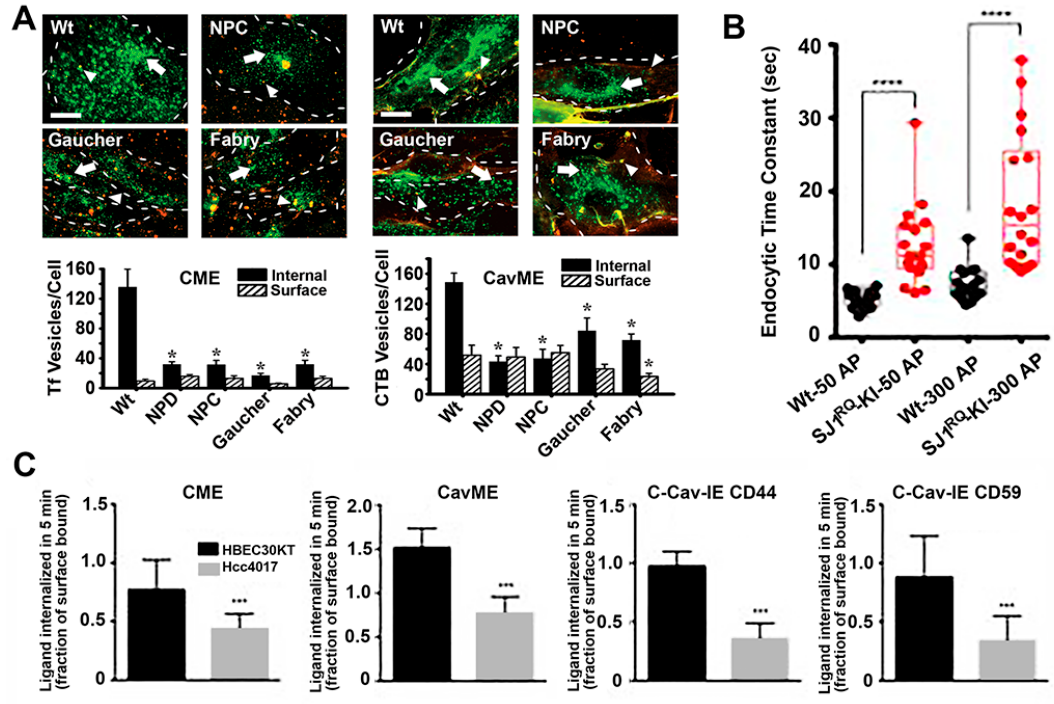
Figure 3. Endocytic alterations caused by disease. ( A ) Micrographs (top panels) and image quantification (bottom graphs) of the uptake of transferrin (Tf; left side) via clathrin-mediated endocytosis (CME) or cholera toxin B (CTB; right side) via caveolae-mediated endocytosis (cavME) in fibroblasts from wild-type (Wt) individuals or patients of Niemann–Pick type A (NPD), Niemann–Pick type C (NPC), Gaucher and Fabry diseases. Green: internalized ligand; yellow-red:cell surface-bound ligand; dashed lines: cell borders; scale bar: 10 μ m. * p < 0.05, Student's t test. ( B ) Endocytosis time constants after short (50 action potentials) or long (300 action potentials) stimulation of cortical neurons from Wt mice vs. mice expressing Parkinson-like R258Q mutation in synaptojanin 1 (SJ1), a molecule involved in synapse endocytic signaling. **** p < 0.00001, Mann–Whitney U test. ( C ) Uptake of endocytic markers in HBEC30KT normal cells vs. Hcc4017 cancer cells from the same patient. C-Cav-IE: Clathrin- and caveolae-independent endocytosis. *** p < 0.0005, Student's t test. Data are mean ± standard error of the mean (SEM) for (A) and (B), and standard deviation (SD) for (C). Adapted and reproduced with permission from: ( A ) Figures 4 and 5 in [94]; ( B ) Figure 5B in [95]. Copyright 2017 Elsevier Inc.; ( C ) Figure 2A in [96]. Copyright 2015 American Association for Cancer Research.